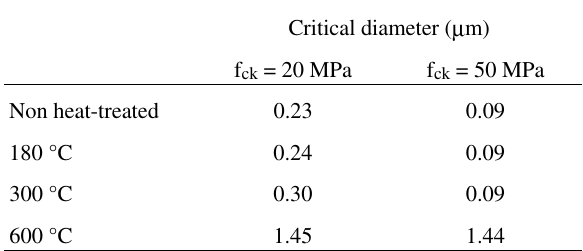
Table 4. Critical diameter measured by mercury intrusion